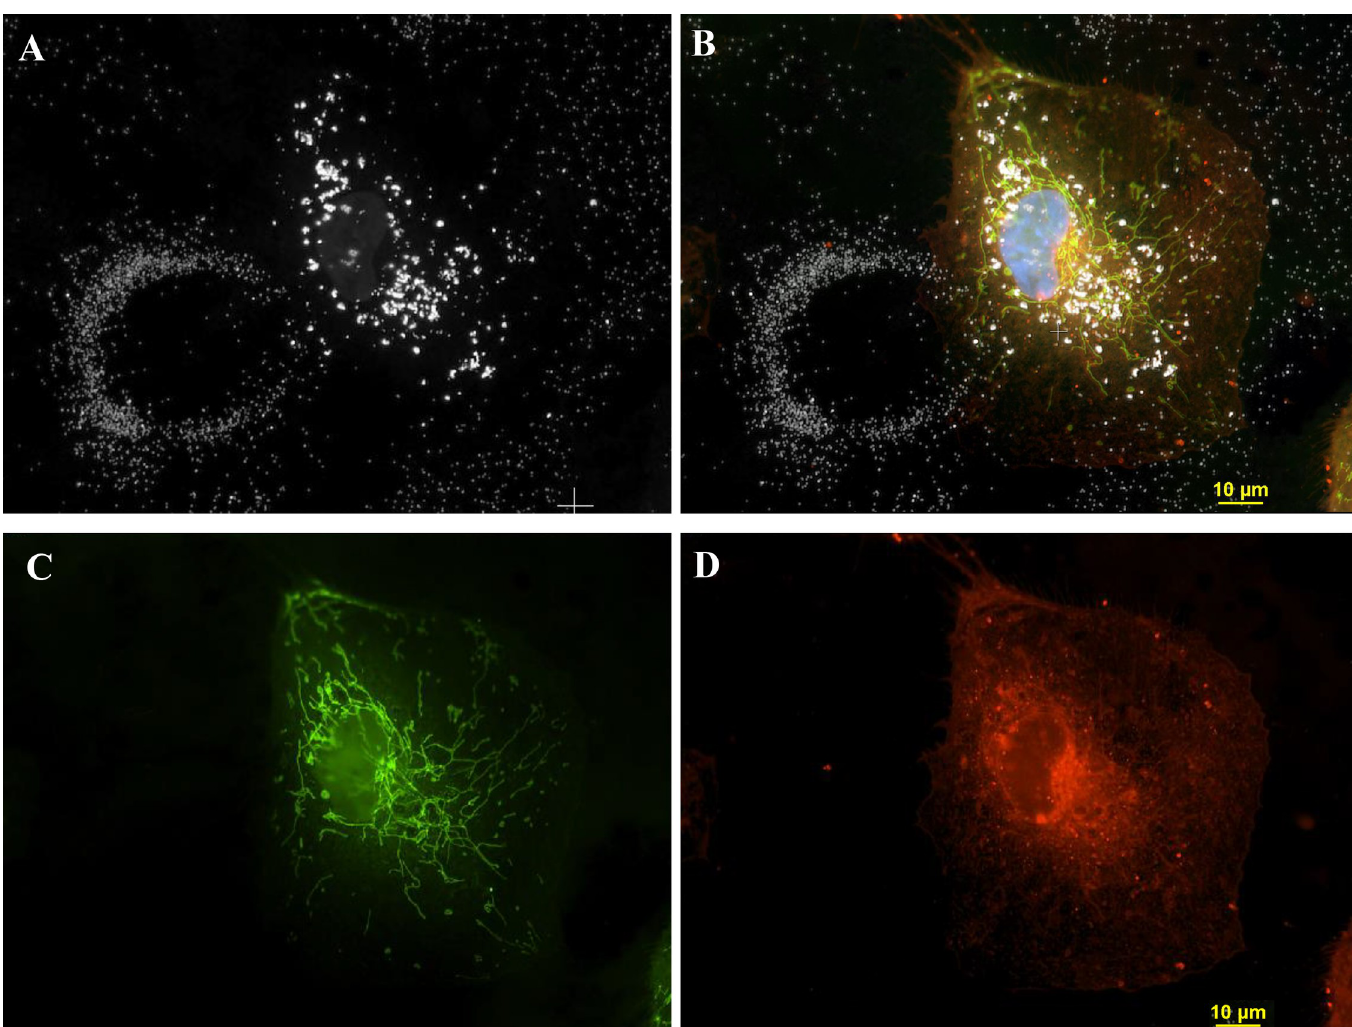
Fig 3. The four-panel figure shows the individual dark field and fluorescent images that were combined into a composite image. A 60-x plan Fluor objective with an iris diaphragm (NA 0.55–0.90 was used to obtain the image. Panel A. A darkfield micrograph of a cell with an adjacent ring structure. The diameter of the circle is 53 μ m and the hole is 32 μ m. The longest direction is 90 μ m and the nuclear diameter is 24 μ m. The intensity of nanoparticles contained in the cell are brighter than the ones contained in the ring structure. Panel B. A composite image consisting of 3 fluorescent images and a darkfield image The composite image was deconvolved using Nikon Autoquant 2D “blind” program, which increased the resolution of the fluorescent probes, especially the Mito- GFP. Panel C. A fluorescent image showing mitochondrial Mito-GFP. (green). Nikon Autoquant 2D “blind” program was used which increased the resolution of the Mito-GFP probe. Panel D. A fluorescent image of the cytoplasm Cell Mask Orange membrane stain. Magnification